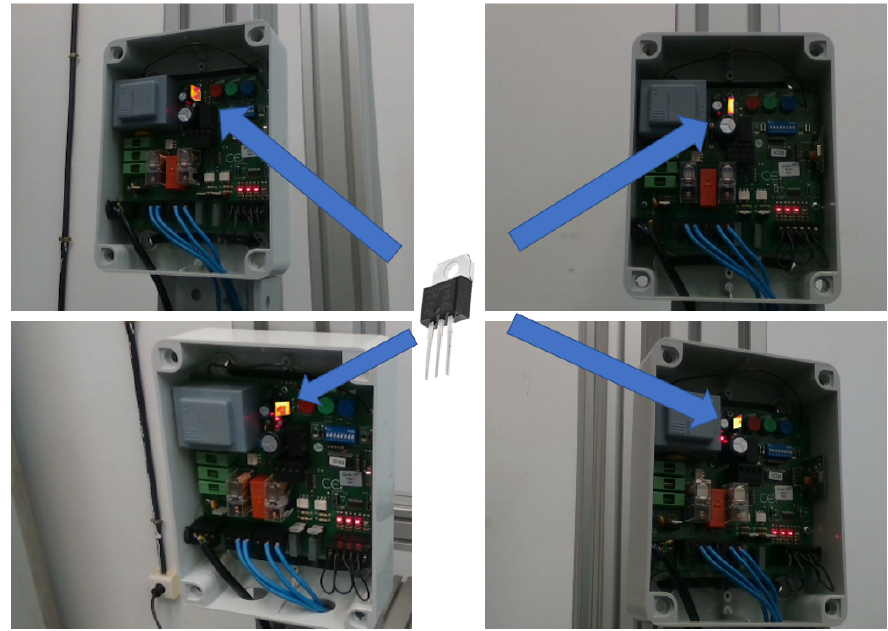
Figure 5. Automatic IRT thermal segmentation of the triac component controlling the power source of the electronic board from different points of